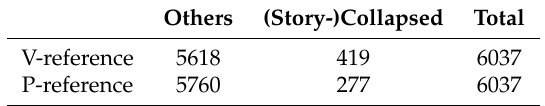
Table 1. Class distribution of the reference data used in this study. V, visual; P,